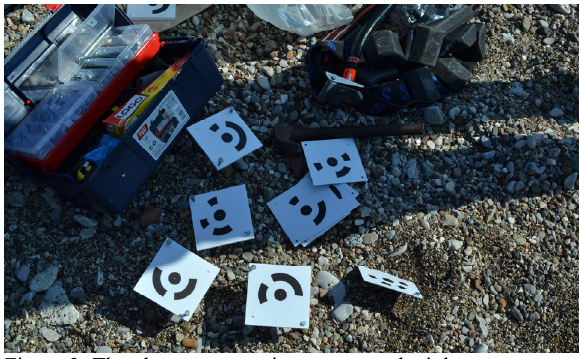
Figure 3: The photogrammetric targets on